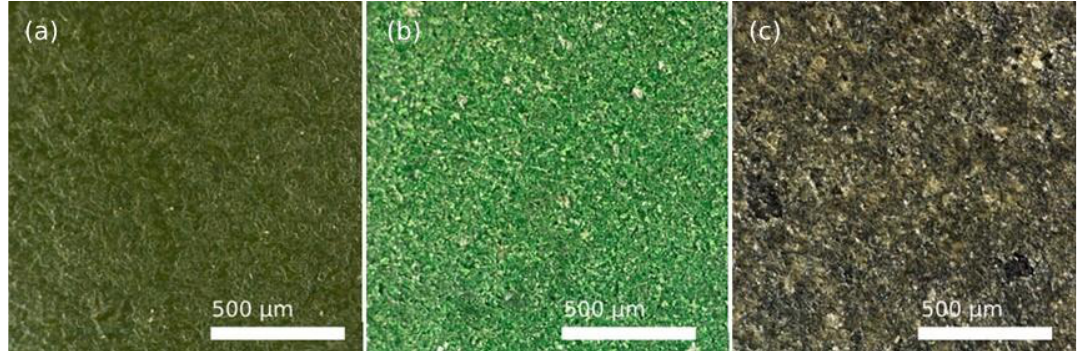
Figure 4. 2D images of the coatings after wear process during 4 s projecting with brown corundum particles at 0.4 MPa, obtained with Leica DVM6 confocal microscope: ( a ) PFA, ( b ) FEP, and ( c ) PTFE.